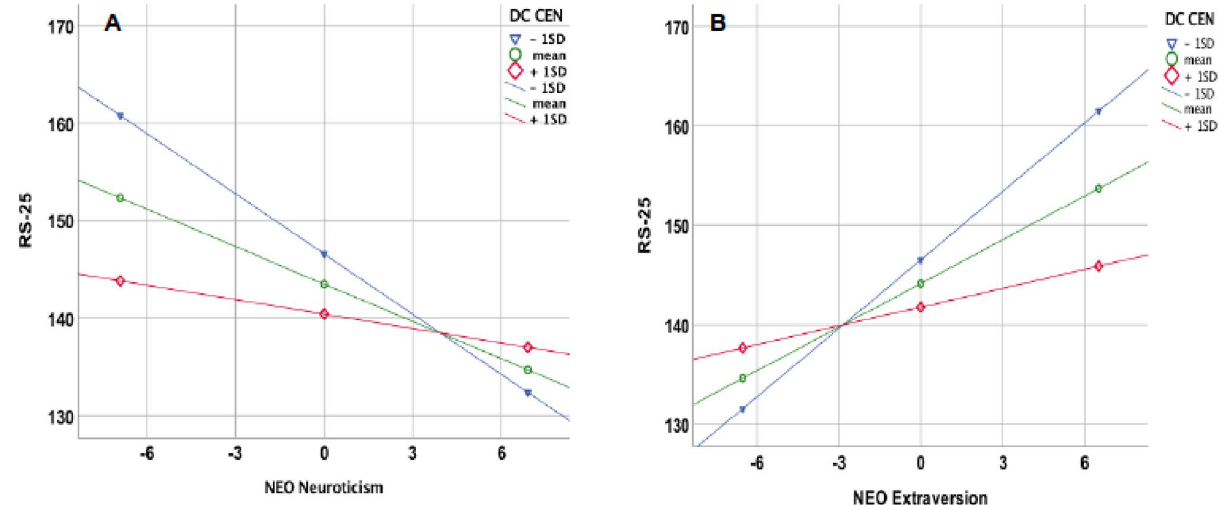
Figure 7. Significant moderation effect of DC in CEN obtained for the correlation of RS-25 with NEO neuroticism ( A ) and NEO extraversion ( B